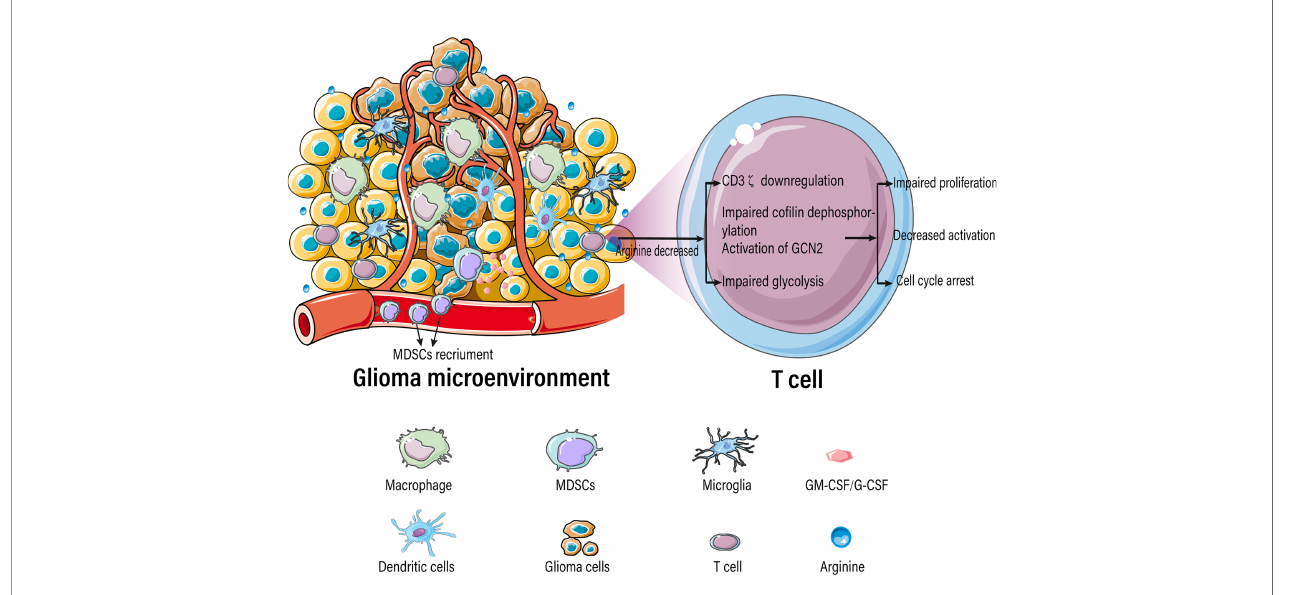
FIGURE 4 | Arginine-de fi cient glioma microenvironment suppresses T-cell